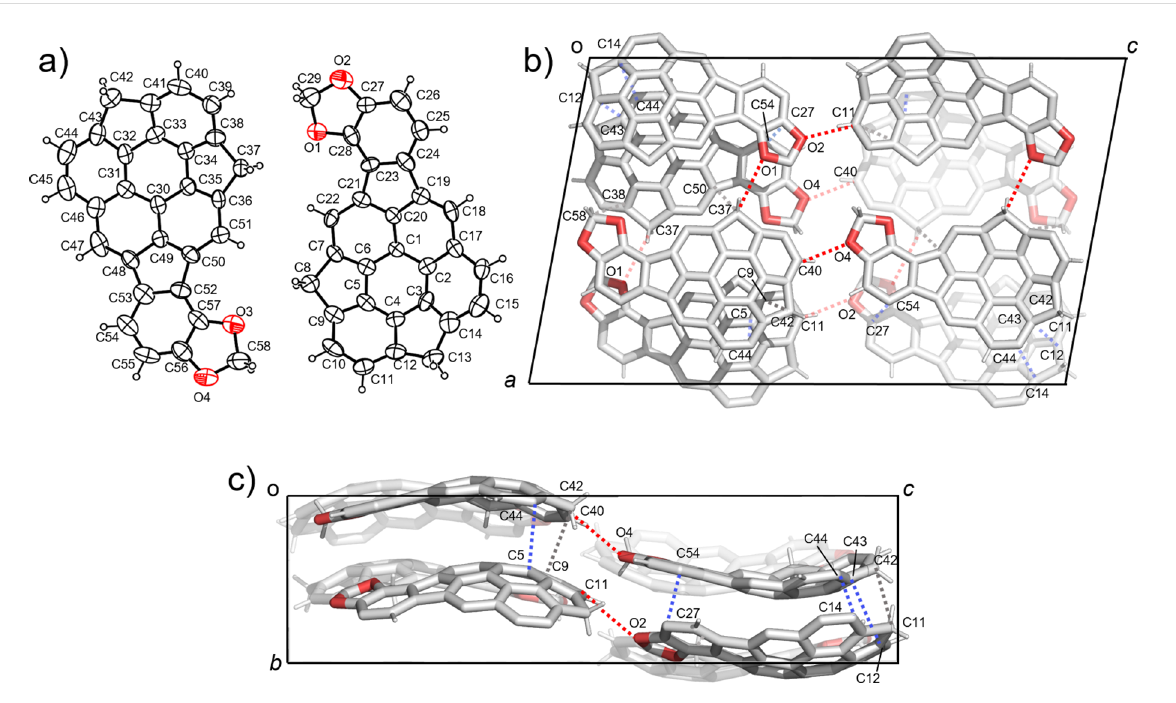
Figure 5: Crystal structure of 5c . a) ORTEP drawing of the crystallographically independent unit with thermal ellipsoid at 50% probability b) Packing structure viewed from the b axis and c) from the a axis. The dotted lines indicate; blue: π – π , grey: CH··· π , red: CH···O interactions. In b) and c), hydro- gen atoms which are not engaged in any interactions are omitted for clarity.